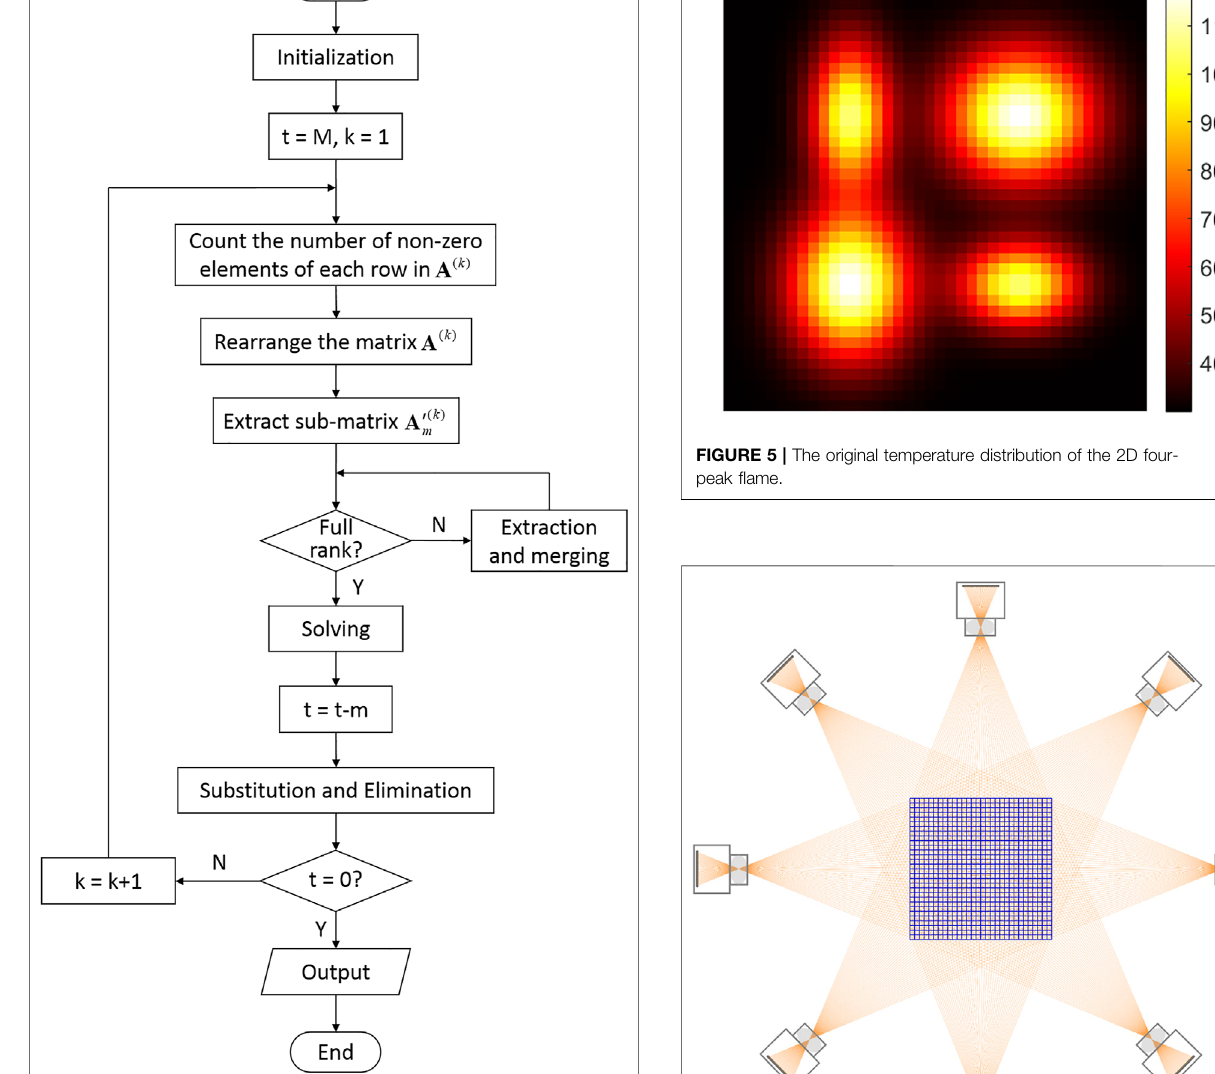
FIGURE 4 | The fl owchart of the direct solution algorithm.